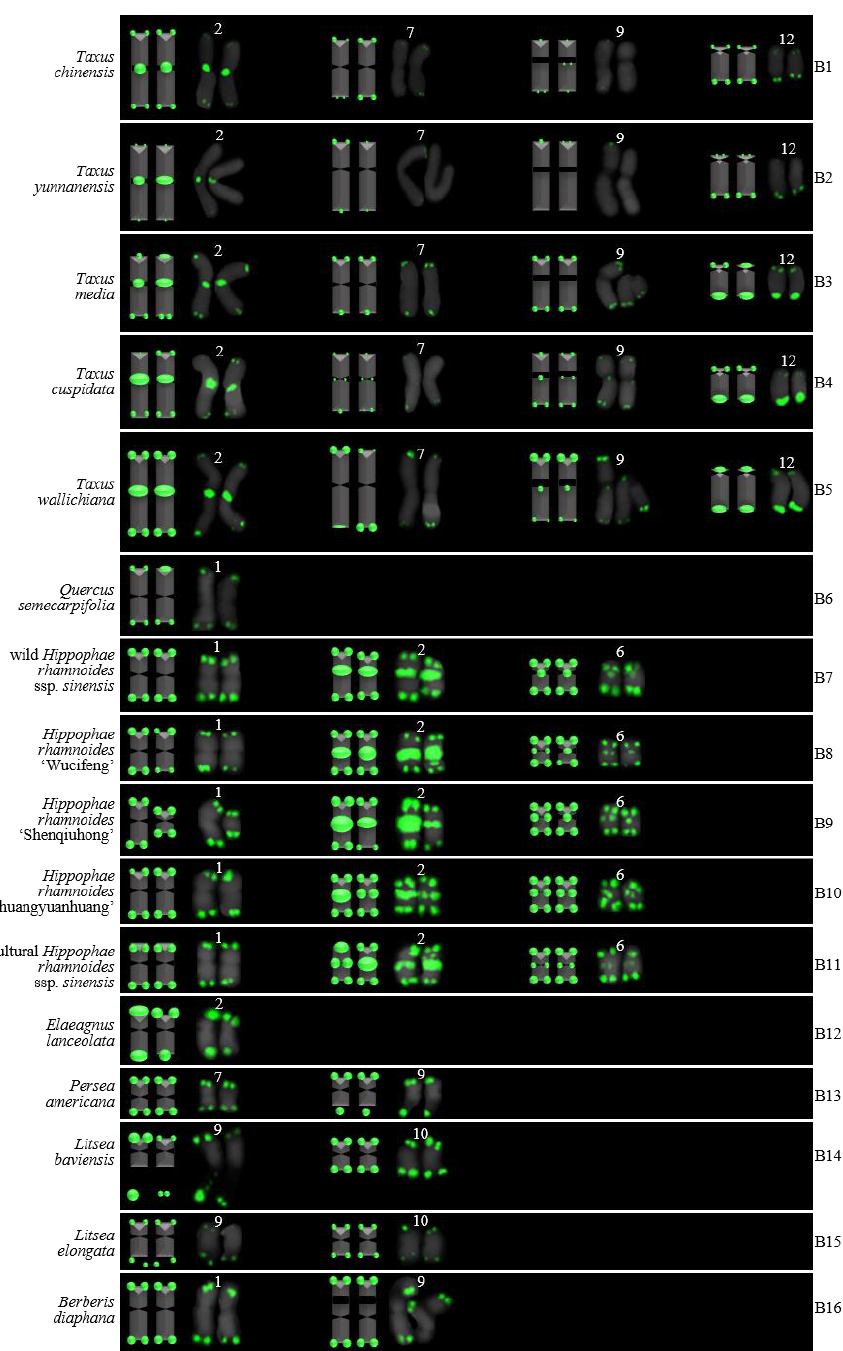
Figure 8. Ideograms of 16 woody plants based on the signal patterns in the FISH karyograms shown in Figure 5: ( B1 ) T. chinensis ; ( B2 ) T. yunnanensis ; ( B3 ) T. media ; ( B4 ) T. cuspidata ; ( B5 ) T. wallichiana ; ( B6 ) Q. semecarpifolia ; ( B7 ) wild H. rhamnoides ssp. sinensis ; ( B8 ) H. rhamnoides ‘Wucifeng’ ; ( B9 ) H. rhamnoides ‘Shenqiuhong’ ; ( B10 ) H. rhamnoides ‘Zhuangyuanhuang’ ; ( B11 ) cultural H. rhamnoides ssp. sinensis ; ( B12 ) E. lanceolata ; ( B13 ) P. americana ; ( B14 ) L. baviensis ; ( B15 ) L. elongate ; and ( B16 ) B. diaphana . The numbers (1, 2, 6, 7, 9, 10, 12) above the karyograms are the numbers of the chromosome pairs. Oligo-probe (AG 3 T 3 ) 3 is exhibited by green signals. Telomeric signals were observed at each